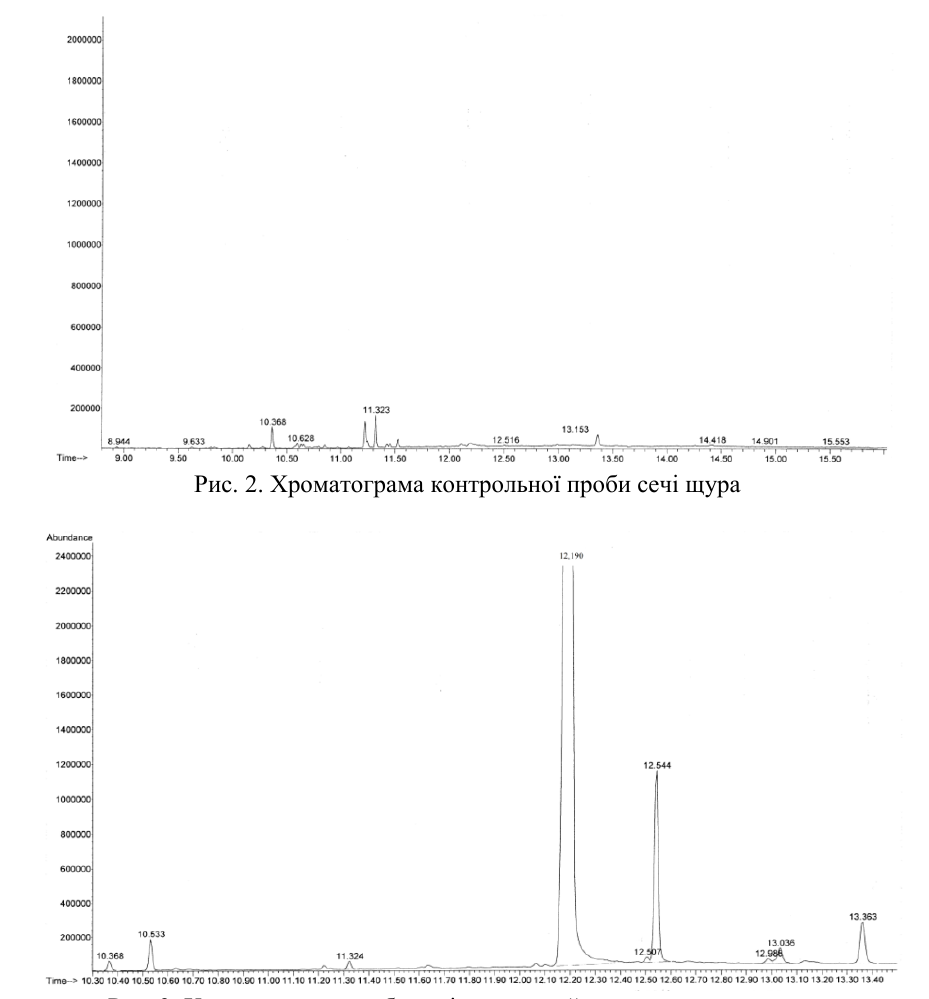
Рис. 3. Хроматограма проби сечі щура, який отримував